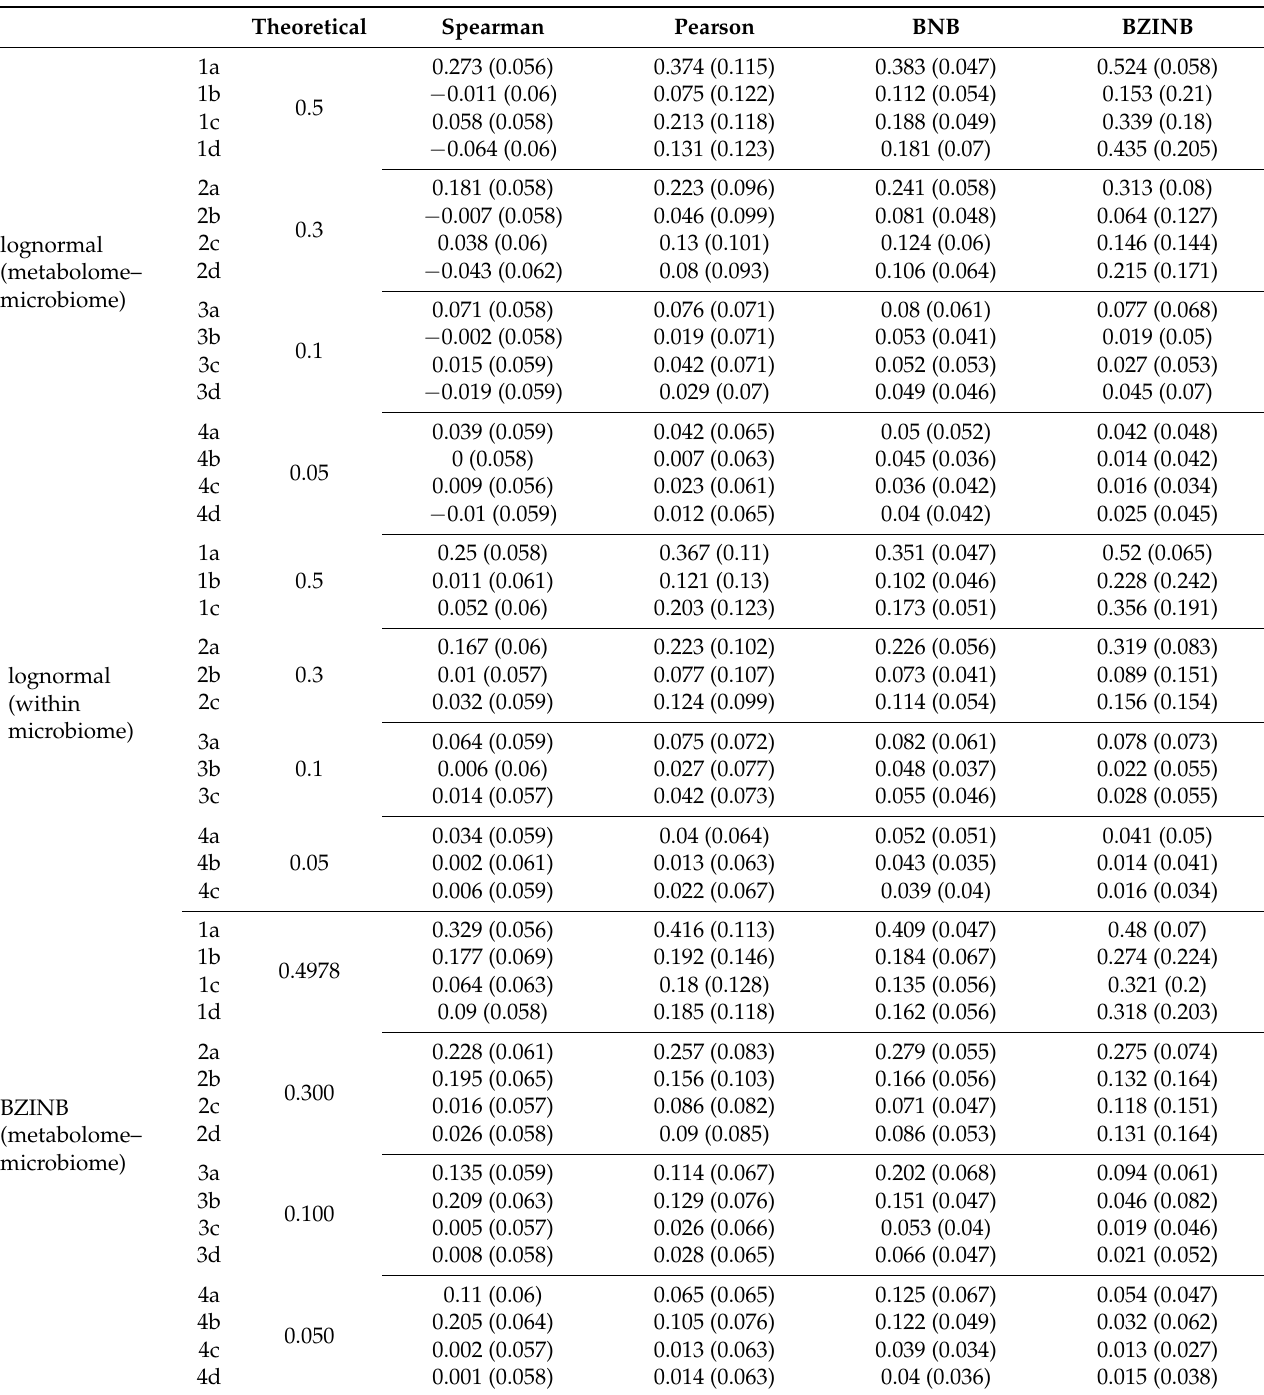
Table A3. The estimated correlations for each set of simulations: median (standard deviation). The number label of each line corresponds to the shape and scale parameters in Appendix A Table A1 or Appendix A Table A2, and the letter label of each line corresponds to the zero inflation parameters in Table 1 or Table